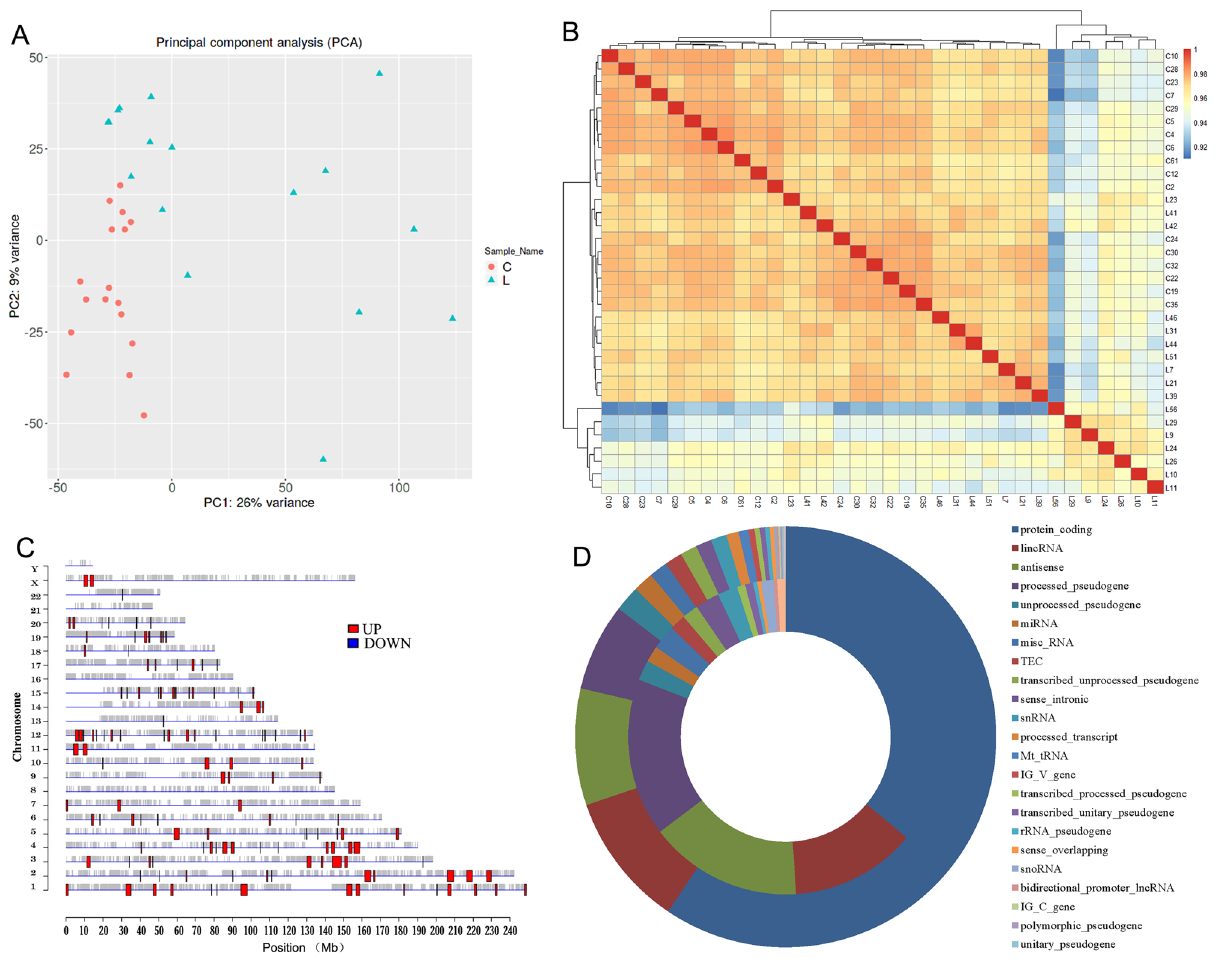
Figure 3. The PCA, heatmap and distribution was created using iDEP version 0.92, http:// bioin forma tics. sdsta te. edu/ idep/ and the pie graph was created using Microsoft office-Excel version 2010, https:// www. micro soft. com/ zh- cn/ micro soft- 365/ micro soft- office. ( A ) Load plot of PCA; ( B ) The pearson’s correlation coefficient of significantly dysregulated mRNA expression the heatmap of inter-sample correlation; ( C ) Distribution of the different expressed genes located in human chromosomes; ( D ) Types of these differential expressed genes sequenced, the outside ring indicated the upregulated genes and the inner ring indicated downregulated genes.